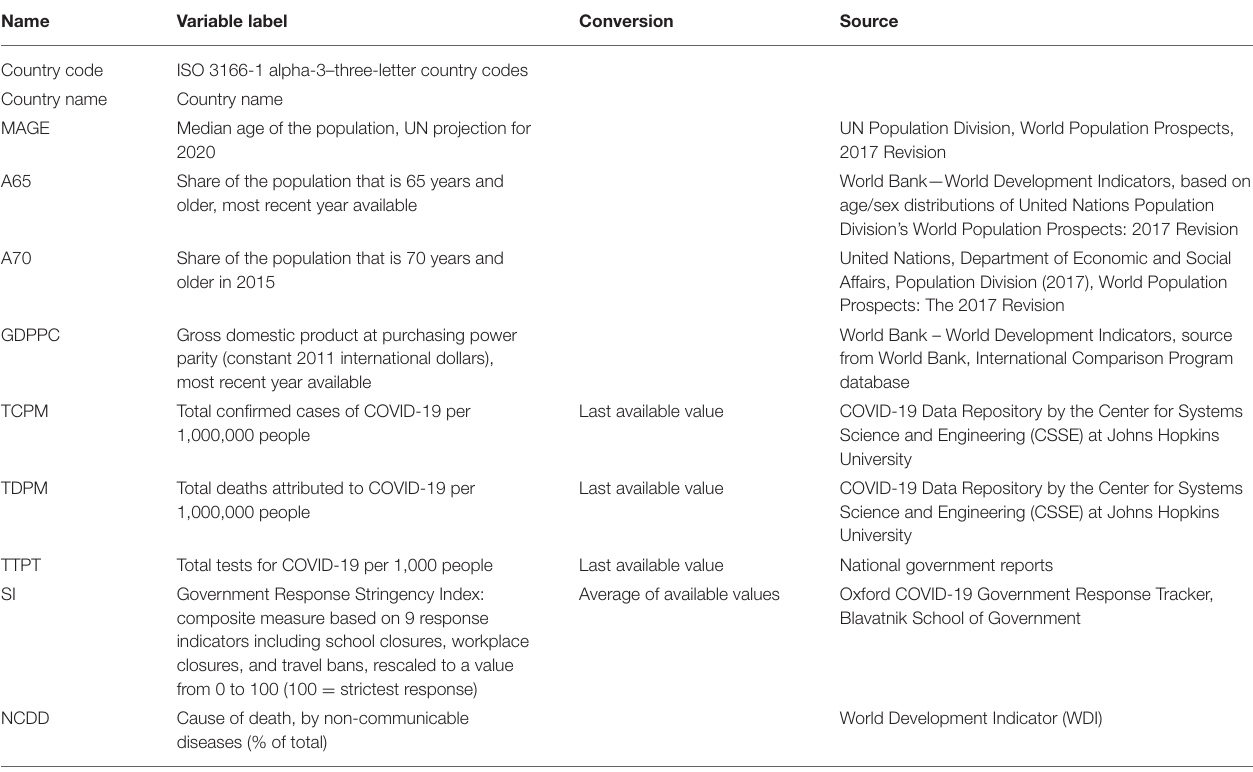
TABLE 2 | Sources of data and variables.